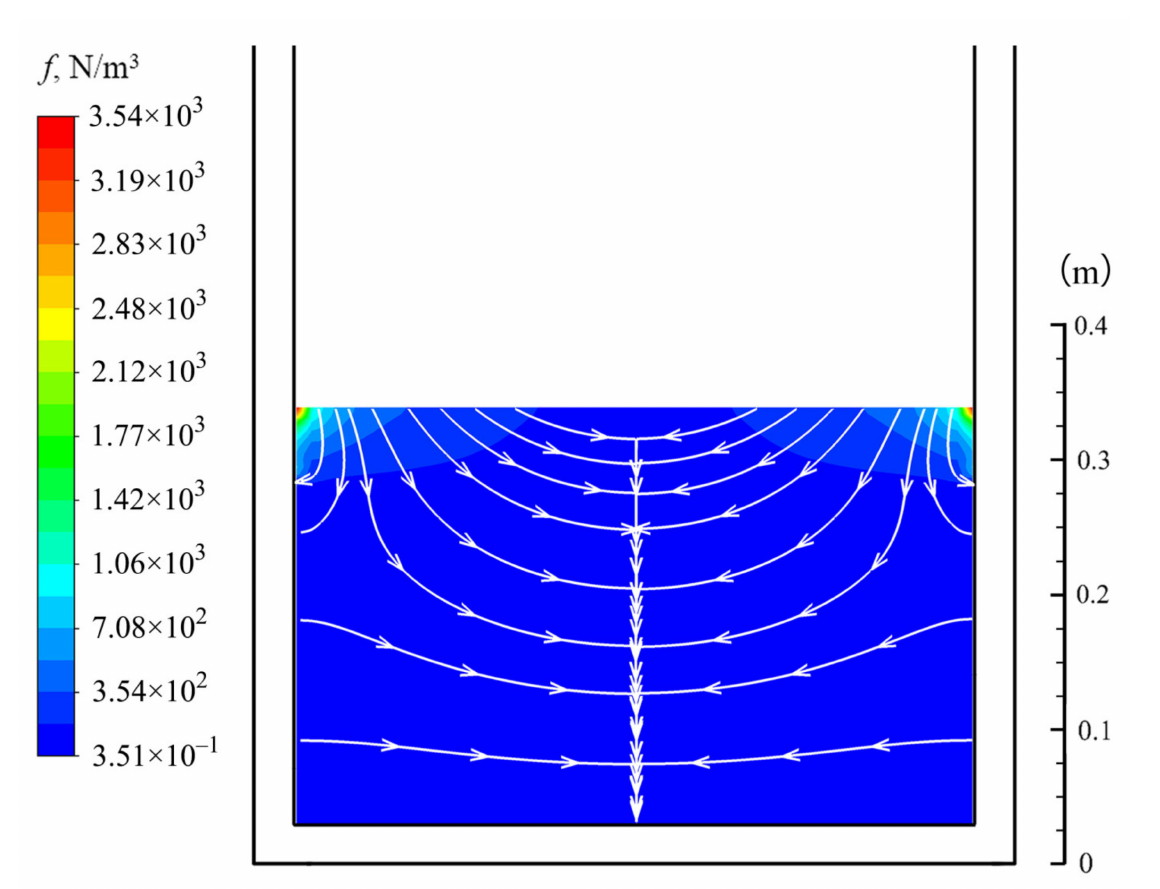
Figure 8. The distribution of the Lorentz force during the VAR